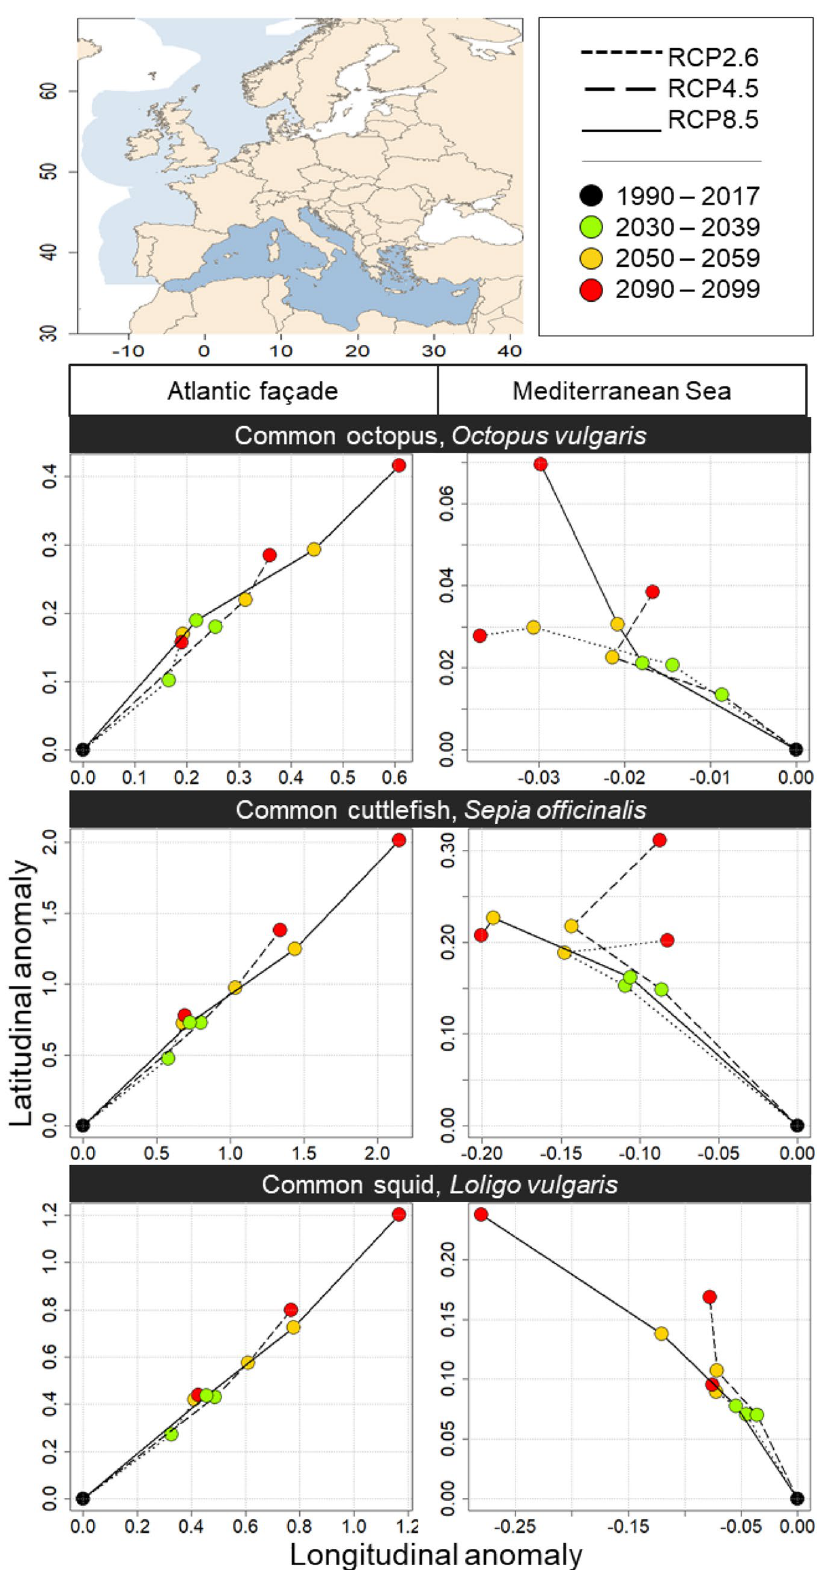
Figure 3. Distributional centroid evolution through space, time and climate change scenarios. The lines correspond to the climate change scenarios and the coloured dots to the different time periods. Left and right panels correspond to the geographical areas, respectively the European Atlantic façade and the Mediterranean Sea. Top, middle and bottom panels represent the three studied species, respectively common octopus, common cuttlefish, and common squid. Note the different scale in each plot. Maps were generated by A.S. using the R v3.4.4 software (R Core Team, 2018; https ://www.R-proje ct.org/), specifically the “sp” and “maptools” package. World borders were retrieved from http://thema ticma pping